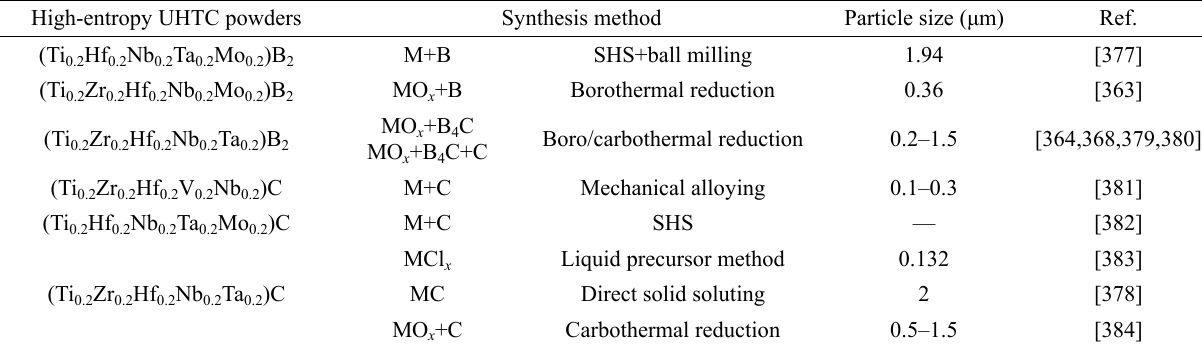
Table 7 Methods for the synthesis of high-entropy UHTC powders High-entropy UHTC